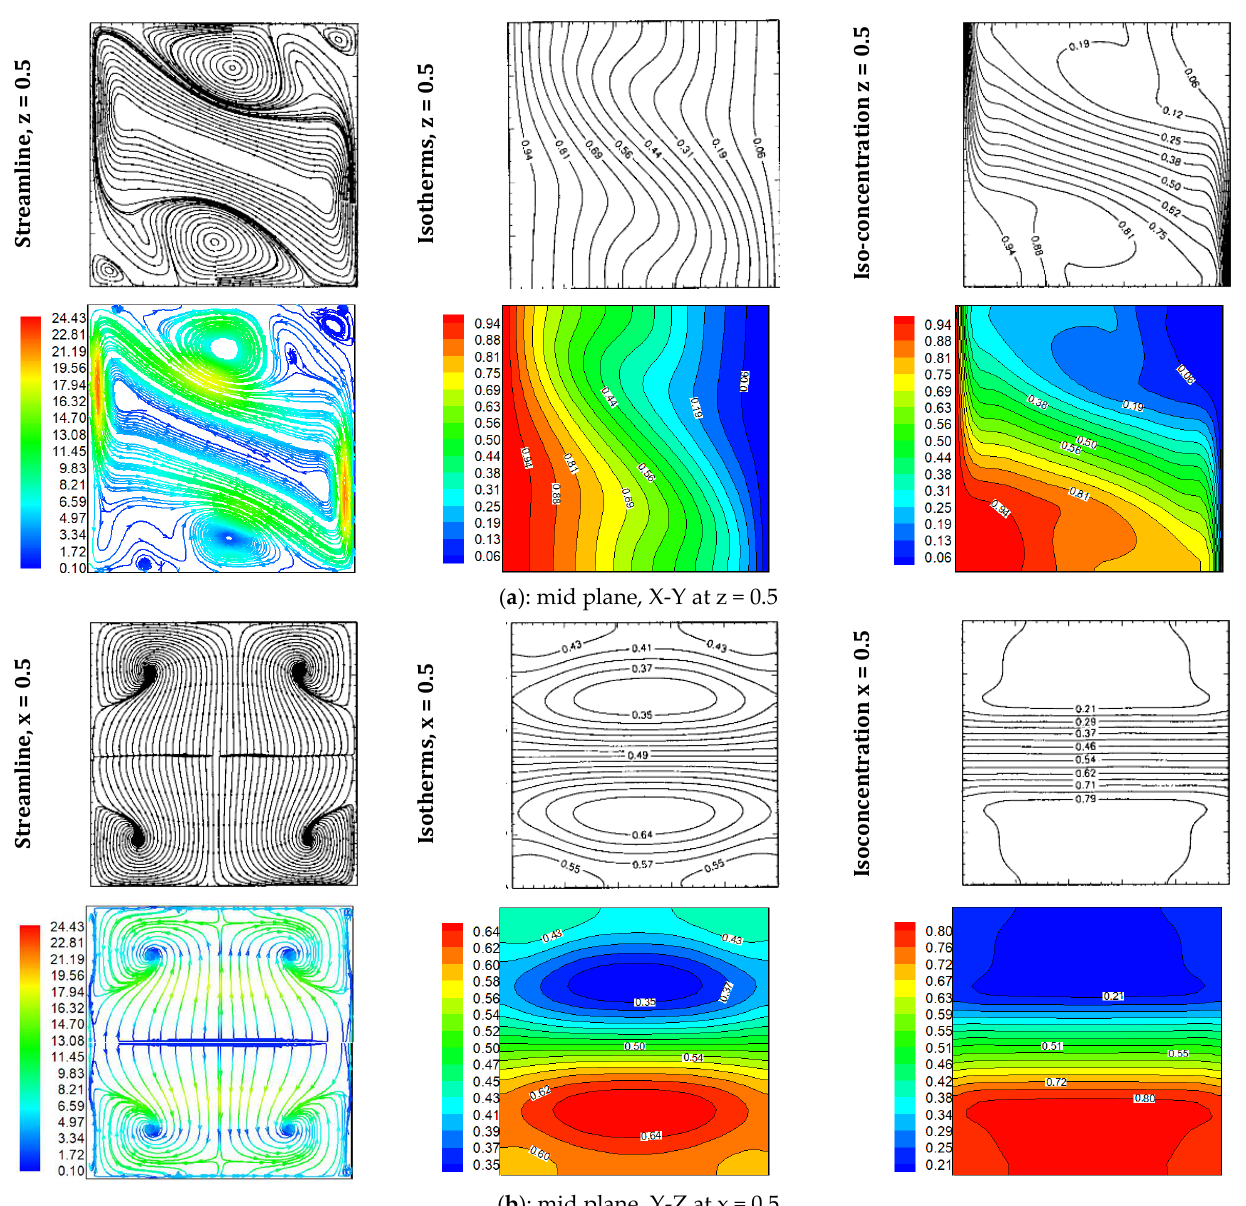
Figure 3. Comparison of the present results (bottom) of Streamlines, iso-temperature and iso-concentration with the results of Sezai and Mohamad [23] (top) at Ra = 10 5 , Pr = 10 and Le = 10, ( a ): X-Y-mid-plane, (z = 0.5) and ( b ): Y-Z-mid plane (x = 0.5).